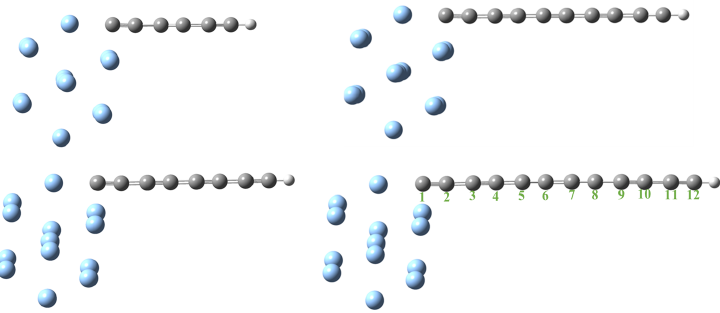
Figure 3. Ag@C 2 n –H, 3 ≤ n ≤ 6, ground-state geometry. Ag NPs and LCCs are represented in cyan and gray-white color,